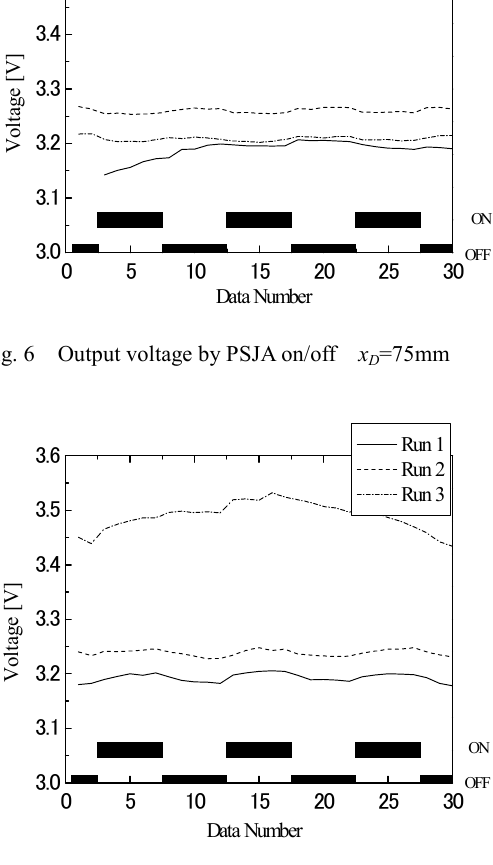
Fig.7 Output voltage by PSJA on/off x D